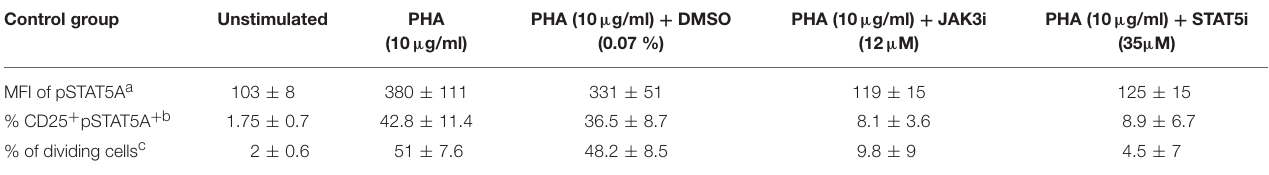
TABLE 2 | Summary of MFI of pSTAT5A, % of CD25 + pSTAT5A + cells and % of dividing cells, before and after treatment with JAK3 and STAT5 inhibitors in PHA stimulated cells ( n = 6). Control